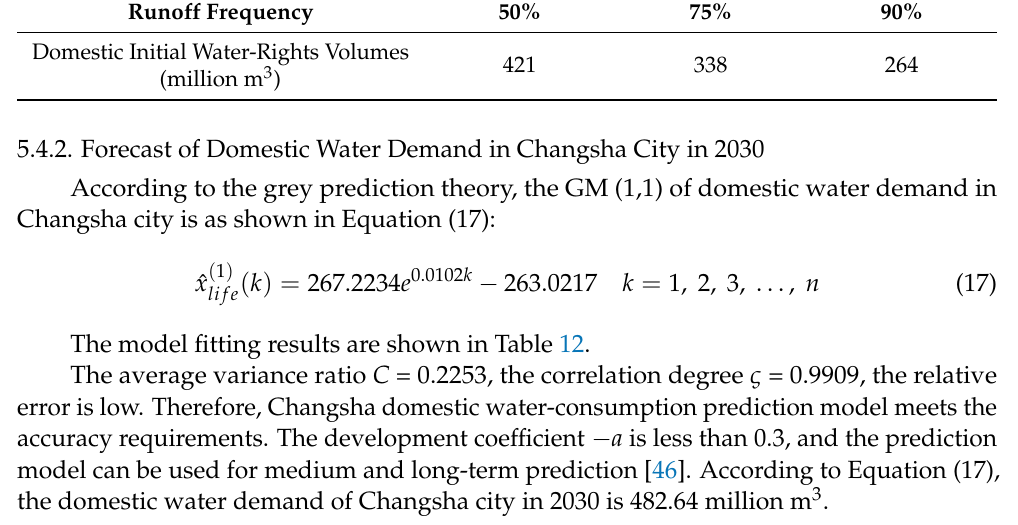
Table 11. The domestic initial water-rights volumes under different runoff frequencies in 2030. Runoff